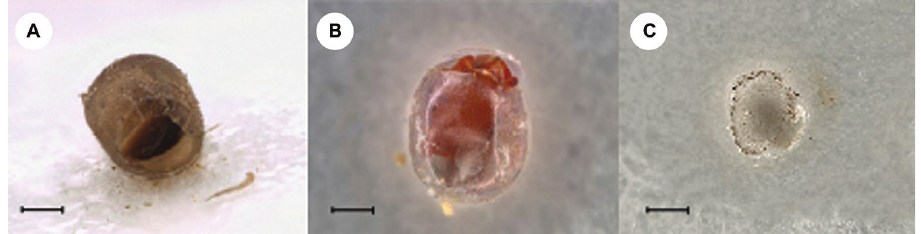
Figure 4. A Bagrada hilaris parasitized egg with the hole for wasp emergence B Bagrada hilaris egg hatching C B. hilaris egg showing signs that is had been eaten by a predator. Scale bars are 0.25 mm. Photo by Roger